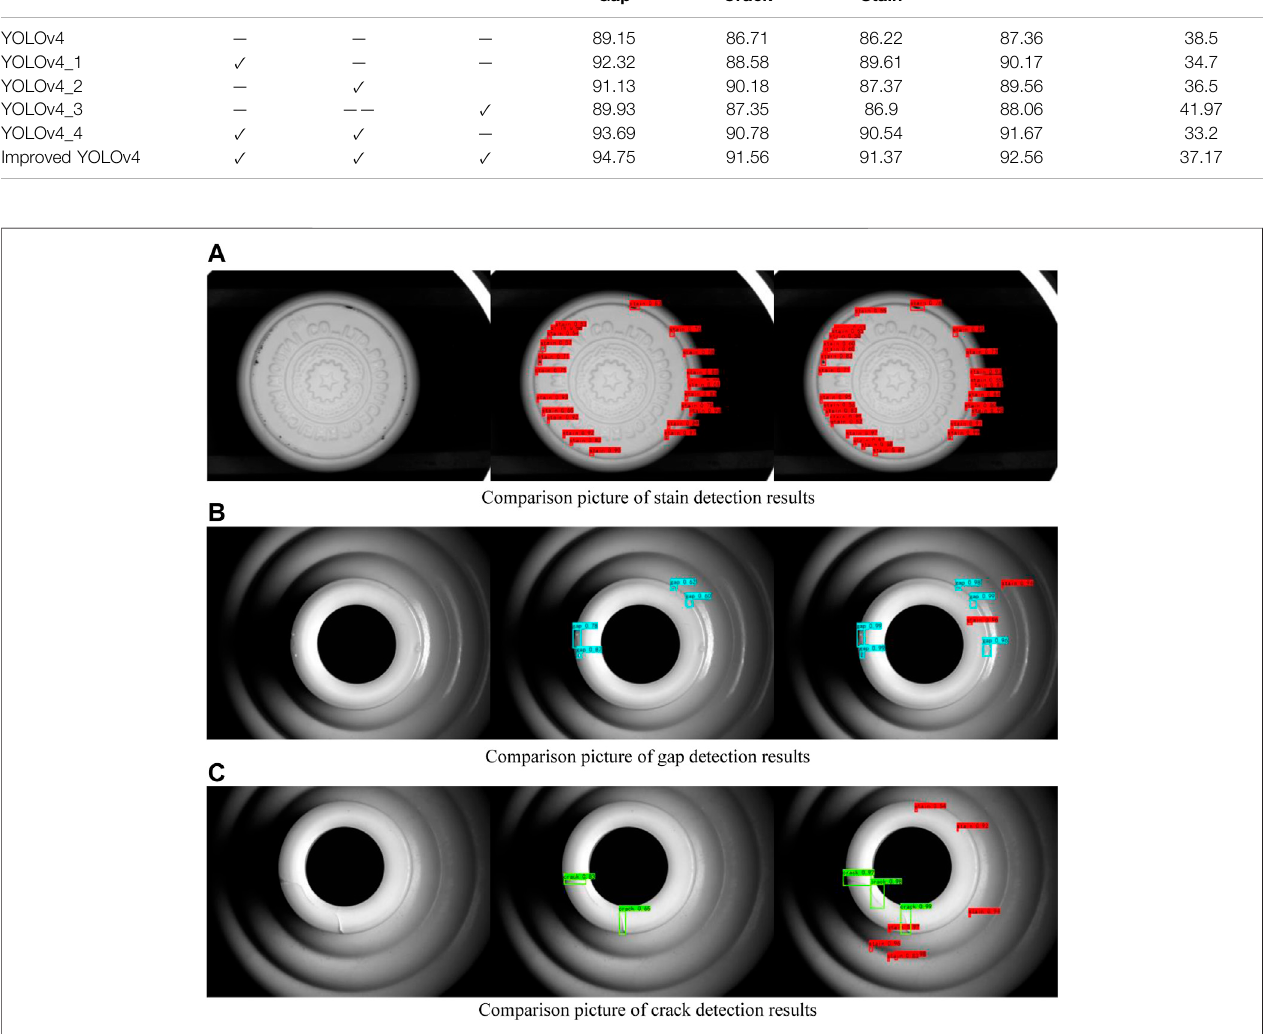
FIGURE9| Comparison ofdetection resultsofdifferent fl awsbetweenthisalgorithmand YOLOv4. (A) isthecontrastdiagramofthegapdetection resultsofwhite porcelain bottle, (B) is the contrast diagram of the crack detection results of white porcelain bottle, (C) is the contrast diagram of the stain detection results of white porcelain